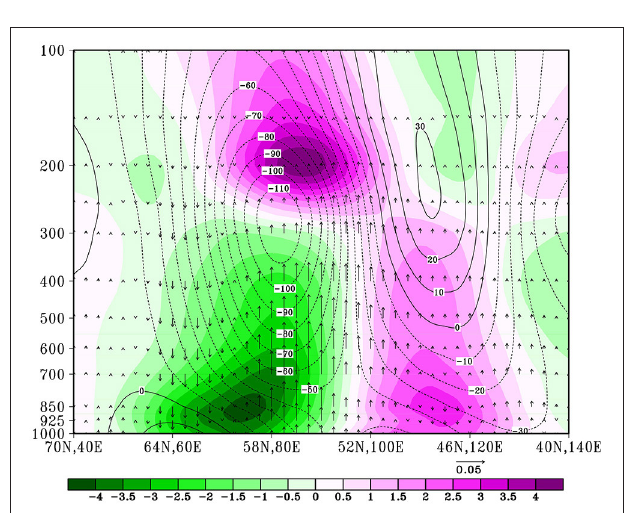
FIGURE 6 | The vertical profiles of composite 10–30-day filtered geopotential height (contour; unit: gpm), temperature (shading; unit: K), and vertical velocity (vector; unit: Pa s − 1 ) anomalies along yellow line at day 0 in Figure 4